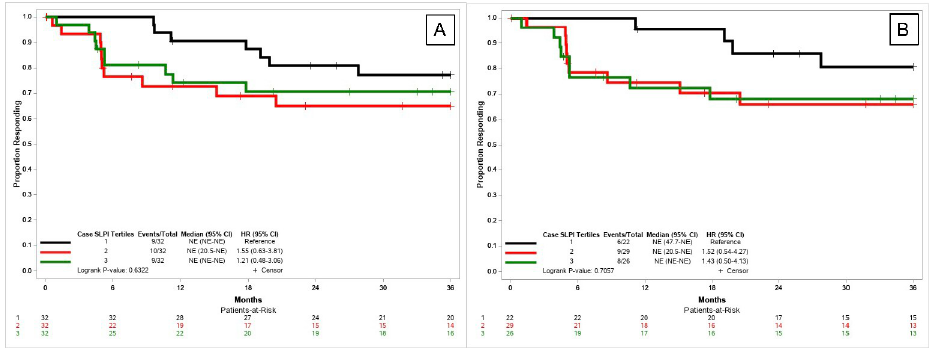
Fig 1. Progression free survival (progressive disease or death) of A) all cases and B) P16+ cases by oral SLPI tertile. SLPI tertiles include T1: < 342.64 ng/mL; T2: 342.65–744.42 ng/mL; and T3: > 744.43